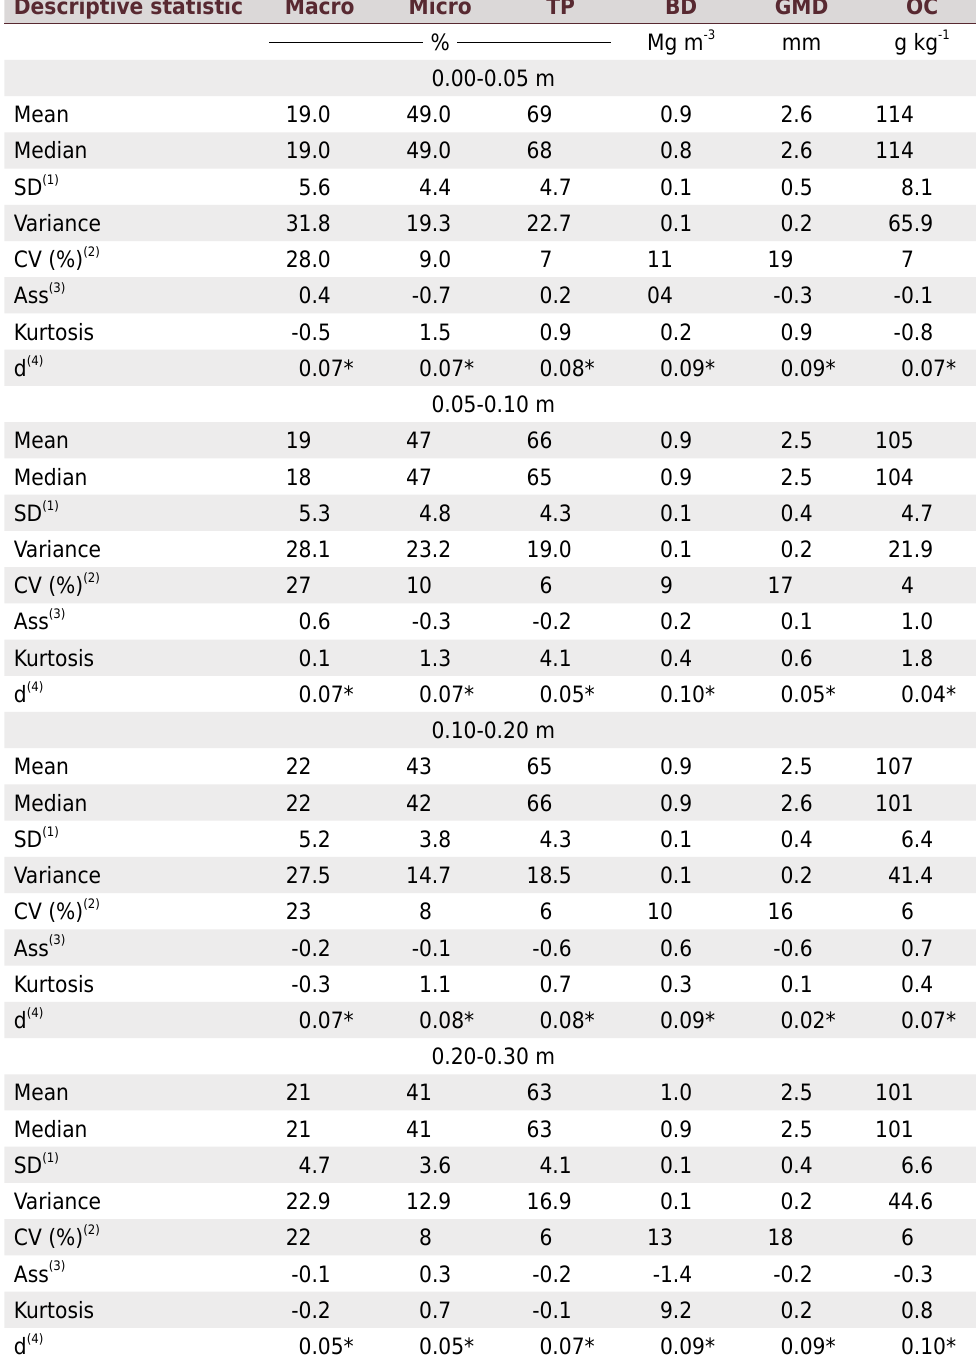
Table 1. Descriptive statistics for soil macroporosity (Macro), microporosity (Micro), total porosity (TP), soil bulk density (BD), geometric mean diameter (GMD), and organic carbon (OC), for four soil layers, in the area of Archaeological Dark Earth under cacao cultivation Descriptive